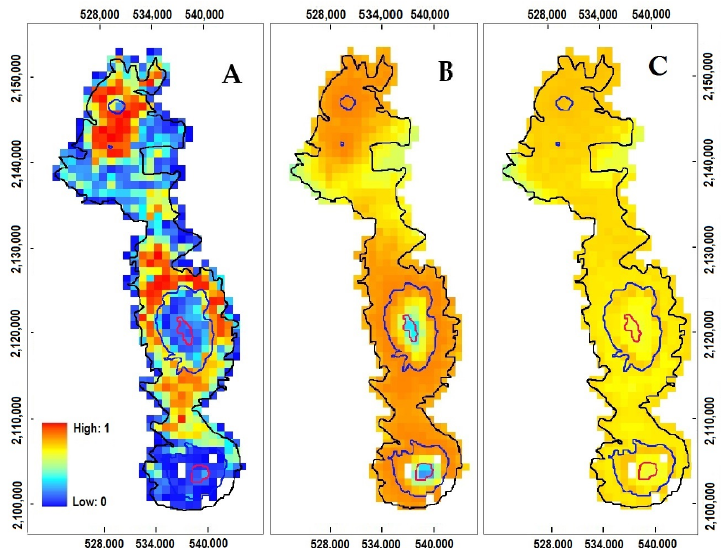
Figure 4. (A): The 2013 Remote sensing data-based map of P. hartwegii ’s occupation (each pixel ranging from 0 to 100% occupation). (B,C): P. hartwegii ’s suitability projections for current climatic conditions of models 5 and 20, respectively. Map lines: Izta-Popo National Park limit (black), 4000 (blue) and 4800 m a.s.l. (red).